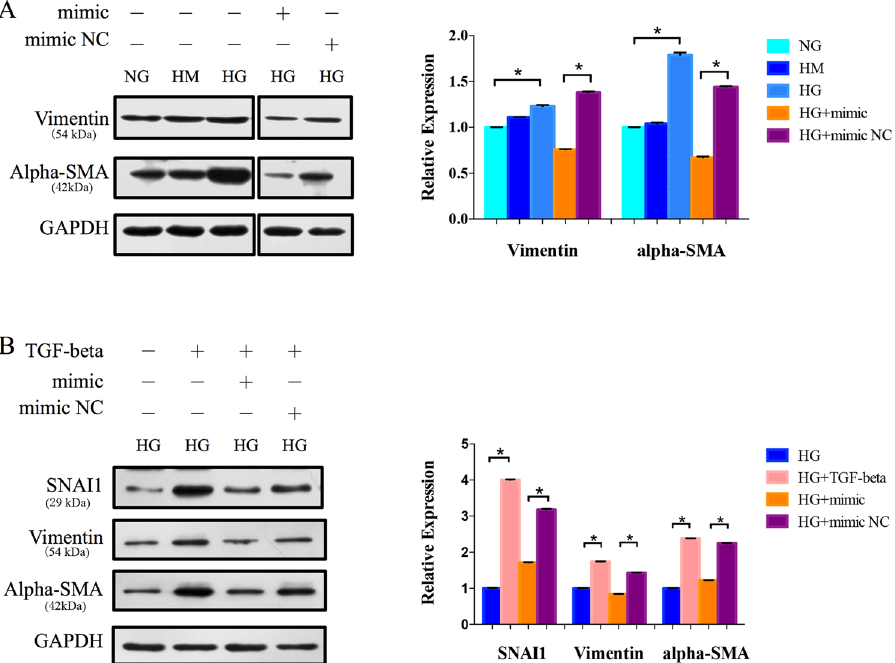
Figure 4. Upregulation of miR-30a-5p repressed EMT. ( A ) Protein expression levels of the EMT markers. The protein expression of vimentin and alpha-SMA was decreased when the LECs were transfected with the miR- 30a-5p mimic in HG conditions ( * P < 0.05, mimic NC as control, N = 2). ( B ) The capsular bags were treated with TGF-beta and a mimic of miR-30a-5p. In the presence of TGF-beta, EMT was induced with the increased protein levels of vimentin and alpha-SMA, as well as SNAI1 ( * P < 0.05, HG without TFG-beta as control, N = 2), while the miR-30a- 5p mimic repressed vimentin and alpha-SMA (P < 0.05, mimic NC as control, N =